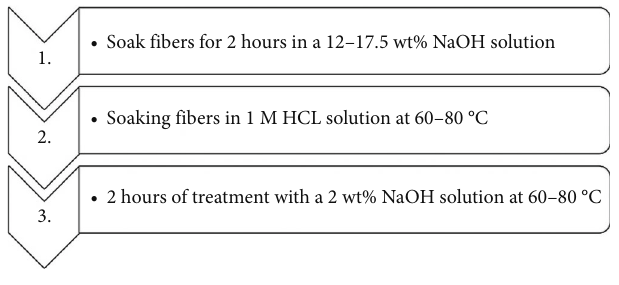
Figure 1: Alkaline treatment procedure